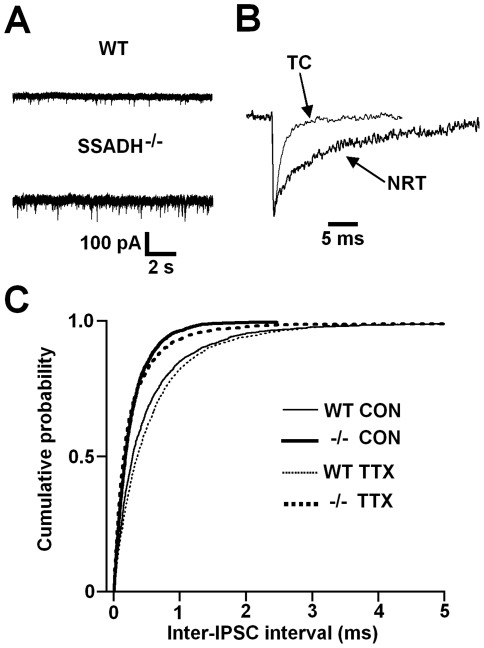
Increased IPSC frequency in NRT neurons of SSADH−/− mice.A, representative current traces from NRT neurons of wild-type (WT, top) and SSADH−/− (bottom) mice showing the difference in spontaneous IPSC frequency between the two genotypes. B, the waveforms of average spontaneous IPSCs from a thalamocortical (TC) neuron of the VB thalamus and an NRT neuron. Note the characteristically slower decay of the IPSC from the NRT neuron compared to the thalamocortical neuron. IPSCs have been normalized to the same peak amplitude. C, cumulative probability plot showing the distribution of inter-IPSC intervals under control conditions (Con) (WT, thin line, 1936 inter-IPSC intervals; SSADH−/−, thick line, 1710 inter-IPSC intervals) and in the presence of 0.5 µM TTX (WT, thin dashed line, 1759 inter-IPSC intervals; SSADH−/−, thick dashed line, 2143 inter-IPSC intervals).